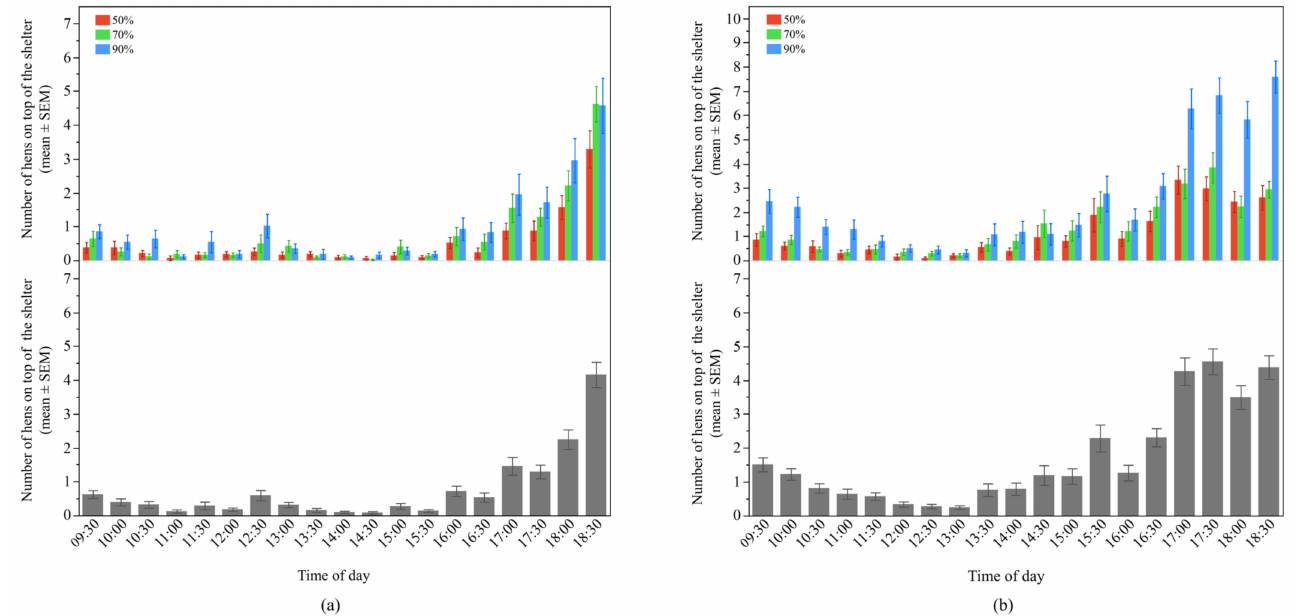
Figure 4. The mean ( ± SEM) number of hens on top of the shelters throughout the day: ( a ) Flock- A: with different UV-filtering percentages (50%, 70%, and 90%) ( top ), on all UV-filtering shelters ( bottom ); ( b ) Flock-B: with different UV-filtering percentages (50%, 70%, and 90%) ( top ), on all UV-filtering shelters ( bottom ). Note the different Y-axis scales between Flock-A and Flock-B for the top graphs. Raw values are presented with analyses conducted on transformed